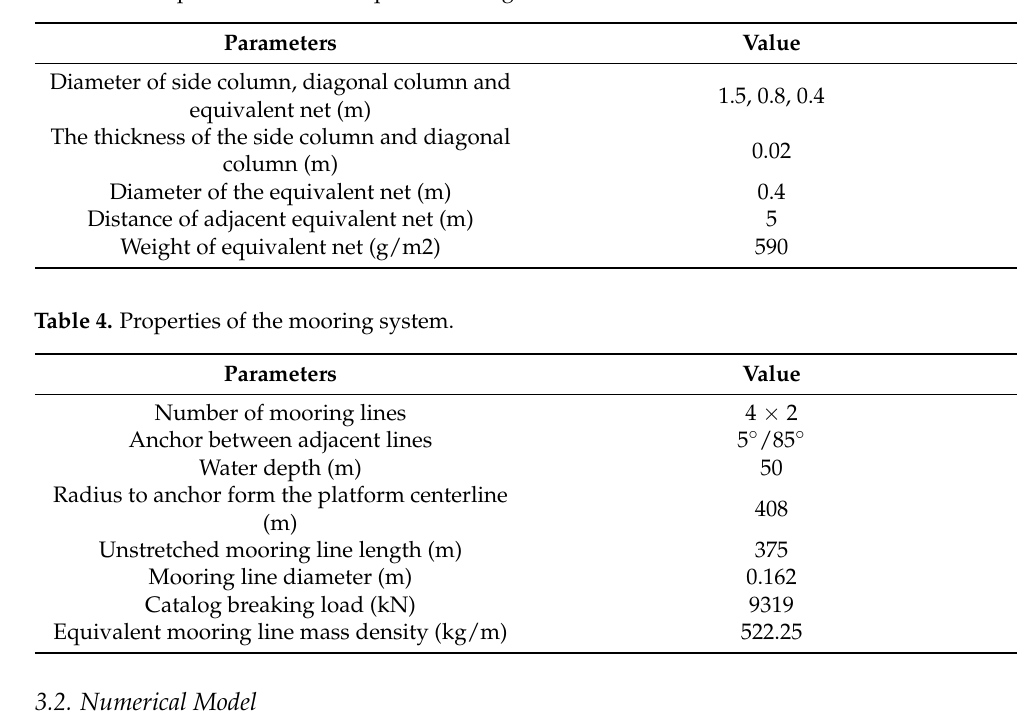
Figure 7. The mesh model of the numerical simulation simplified, where mooring line 1 to 8 are marked. The flow chart of numerical simulation for barge-type FOWT-AC is illustrated in Fig- ure 8. The FOWT-AC structure is composed of four parts from top to bottom, namely, wind turbine, barge platform, aquaculture cage and mooring system, and is coupled by three external loads of wind, wave and currents with its own structural motions. The wind turbine and above-water parts of the platform are subjected to the aerodynamics, while the underwater parts of the platform, aquaculture cage and mooring system suffer hydro- dynamics. As indicated previously, the wind loads are set by the dynamic link library using user-force; the hydrodynamics of the platform and aquaculture cage are simulated by the potential flow theory and Morison equation; the tension of the mooring system is calculated by quasi-static theory [45]. Moreover, the operating state will be determined by the control system according to the dynamic response state of the wind turbine. The cou- pling effects mentioned in the above determine the final dynamic characteristics of the integrated FOWT-AC system.